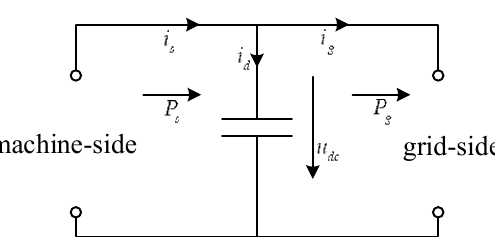
Figure 3. Schematic diagram of energy Figure 3. schematic diagram of energy flow.